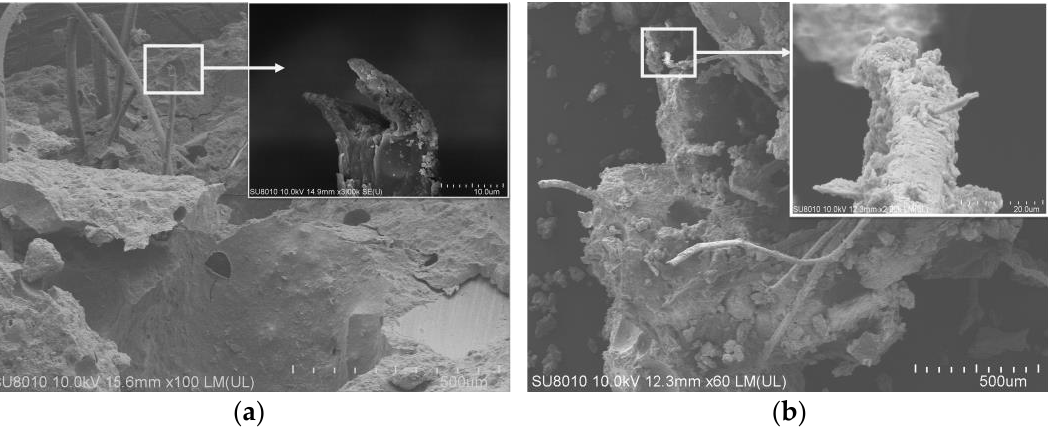
Figure 5. SEM image of joining EVA. ( a ) is the fracture state of the PVA fiber; ( b ) is the “polymer film on fiber surface”.